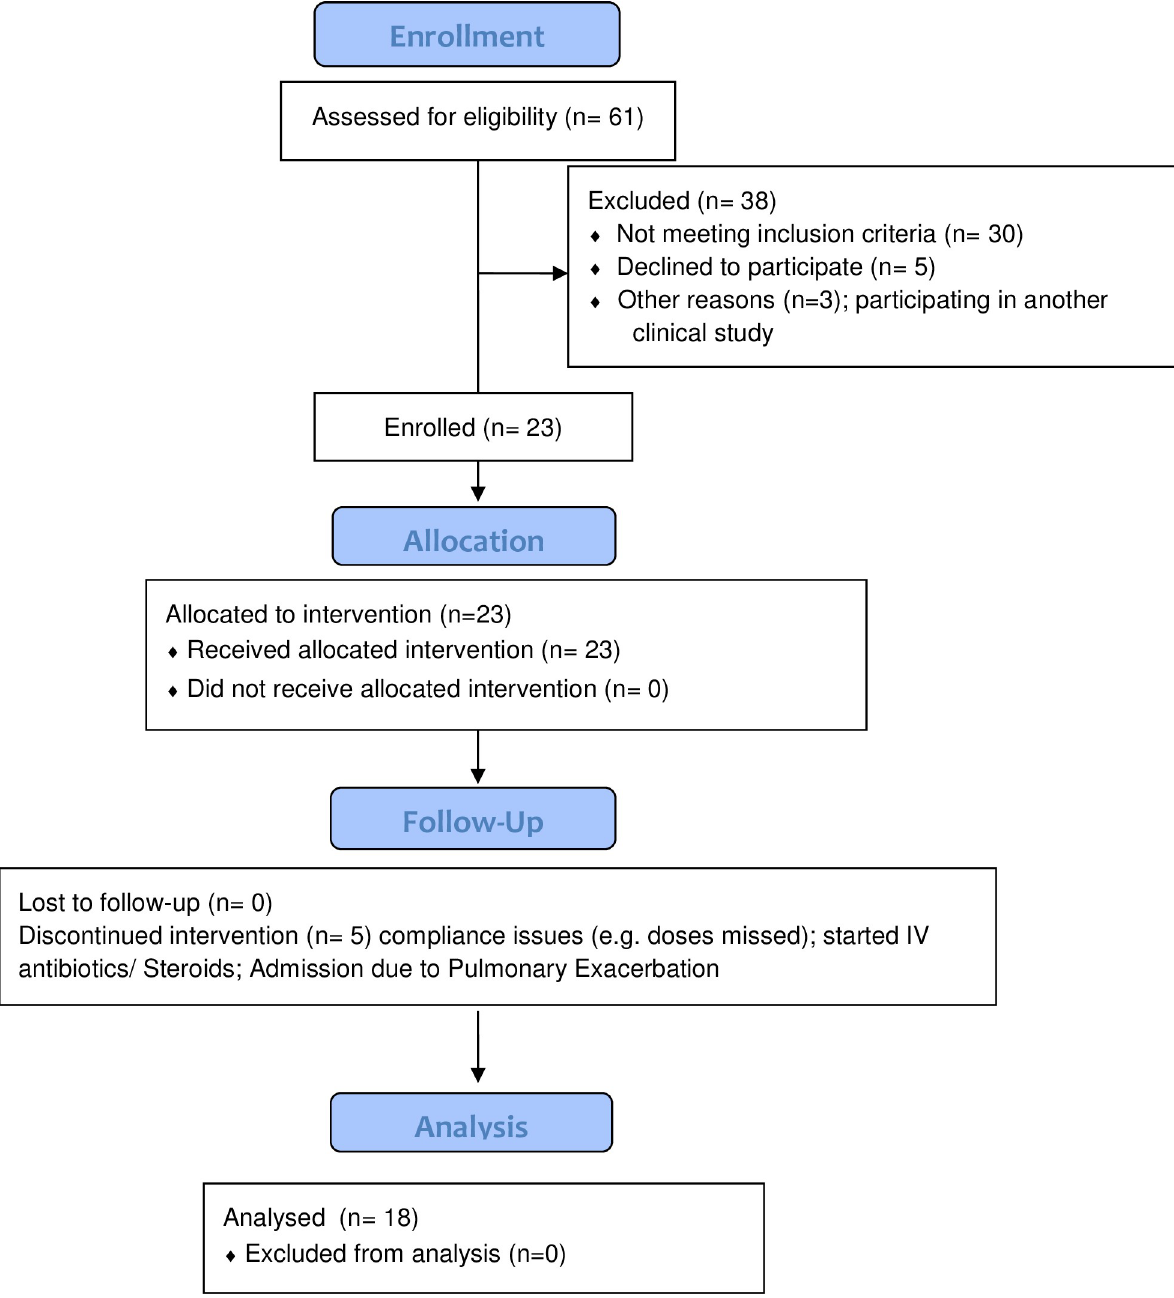
Fig 1. Study CONSORT